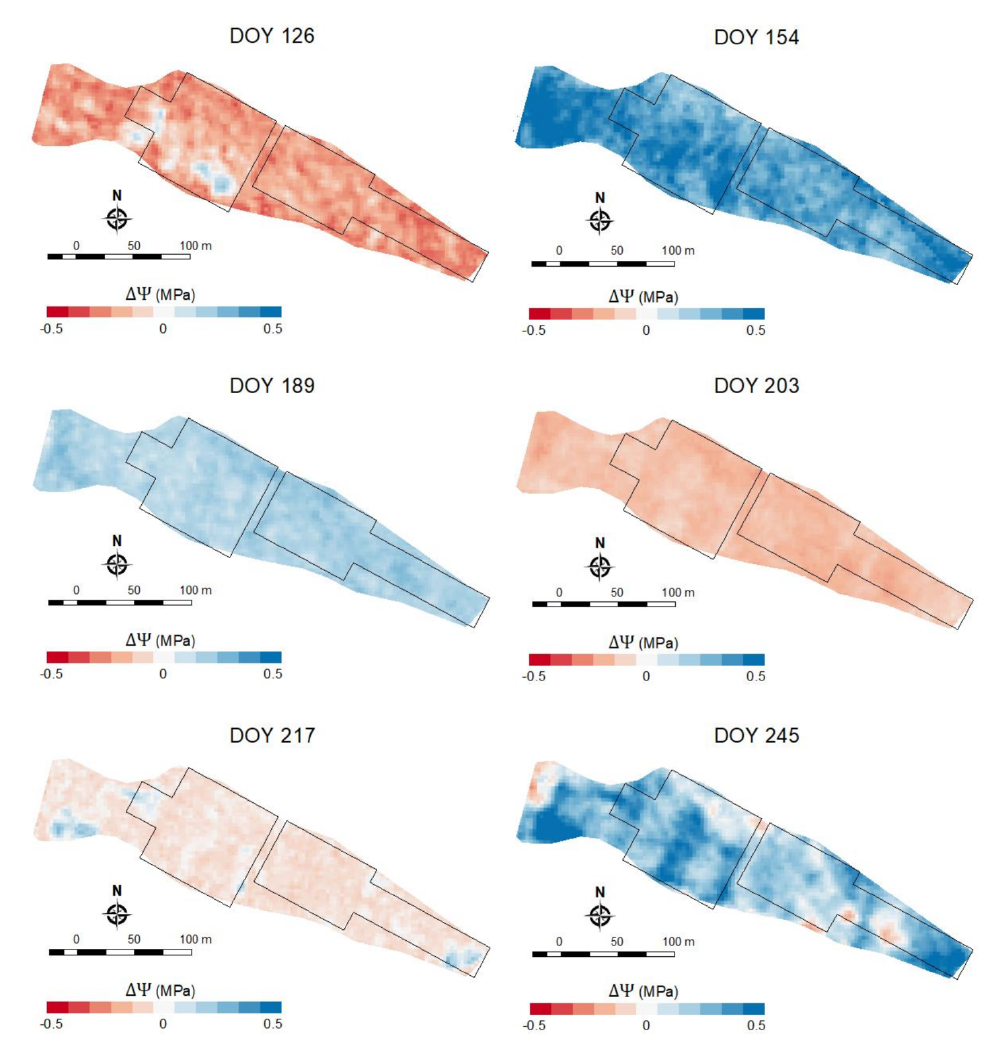
Figure 5. The difference between the Ψ stem maps retrieved from MB-Mult and MB-Reg , both using SAVI ( ∆Ψ ). ∆Ψ is the absolute Ψ stem value from MB-Reg minus the absolute Ψ stem value from MB-Mult ; therefore, blue color indicates a lower Ψ stem value (more stressed) in MB-Reg compared to MB-Mult , while red color indicates a higher Ψ stem value (less stressed) in MB-Reg compared to MB-Mult